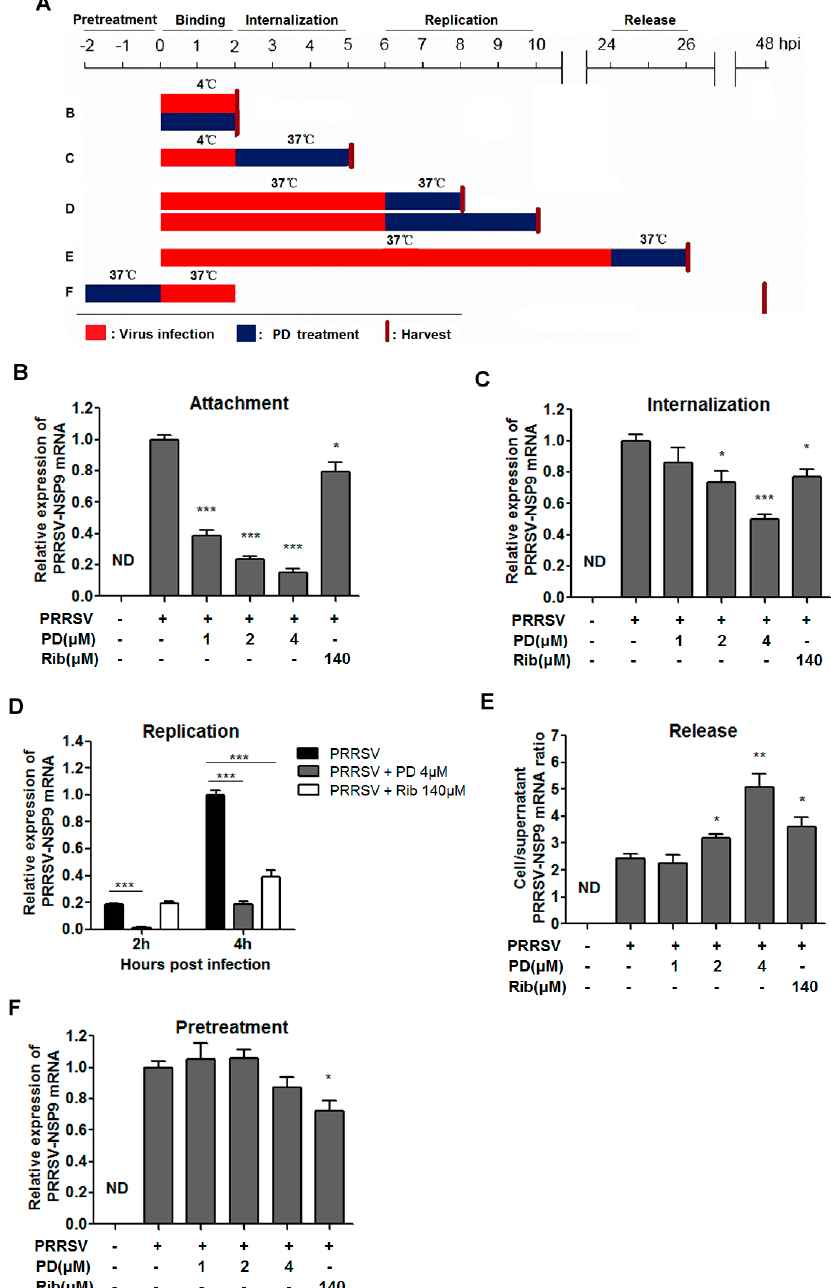
Figure 4. PD inhibits PRRSV entry, replication and release. MARC-145 cells were infected with the PRRSV GD-HD strain at 0.5 or 0.05 MOI. The infected cells were cultured in the presence of various PD concentrations and collected at the indicated time-points post infection to determine viral NSP9 mRNA level by RT-PCR. Cellular GAPDH mRNA was used as a loading control and DMSO-treated sample (set as 1) was used as a reference control. ( A ) Different PD treatment schemes. Red bars represent PRRSV infection period, blue bars represent PD treatment period, and red vertical bars represent end of treatments and cell harvesting. ( B ) Viral binding was investigated following treatment B; ( C ) Viral internalization was investigated following treatment C; ( D ) Viral replication following treatment D; ( E ) Viral release following treatment E; and ( F ) PD pretreatment was performed by treatment F. For B and C, 0.5 MOI PRRSV were used to infect cells; For D and E and F , 0.05 MOI PRRSV were used to infect cells. Statistical significances are denoted by * p < 0.05, ** p < 0.01, and *** p < 0.001.